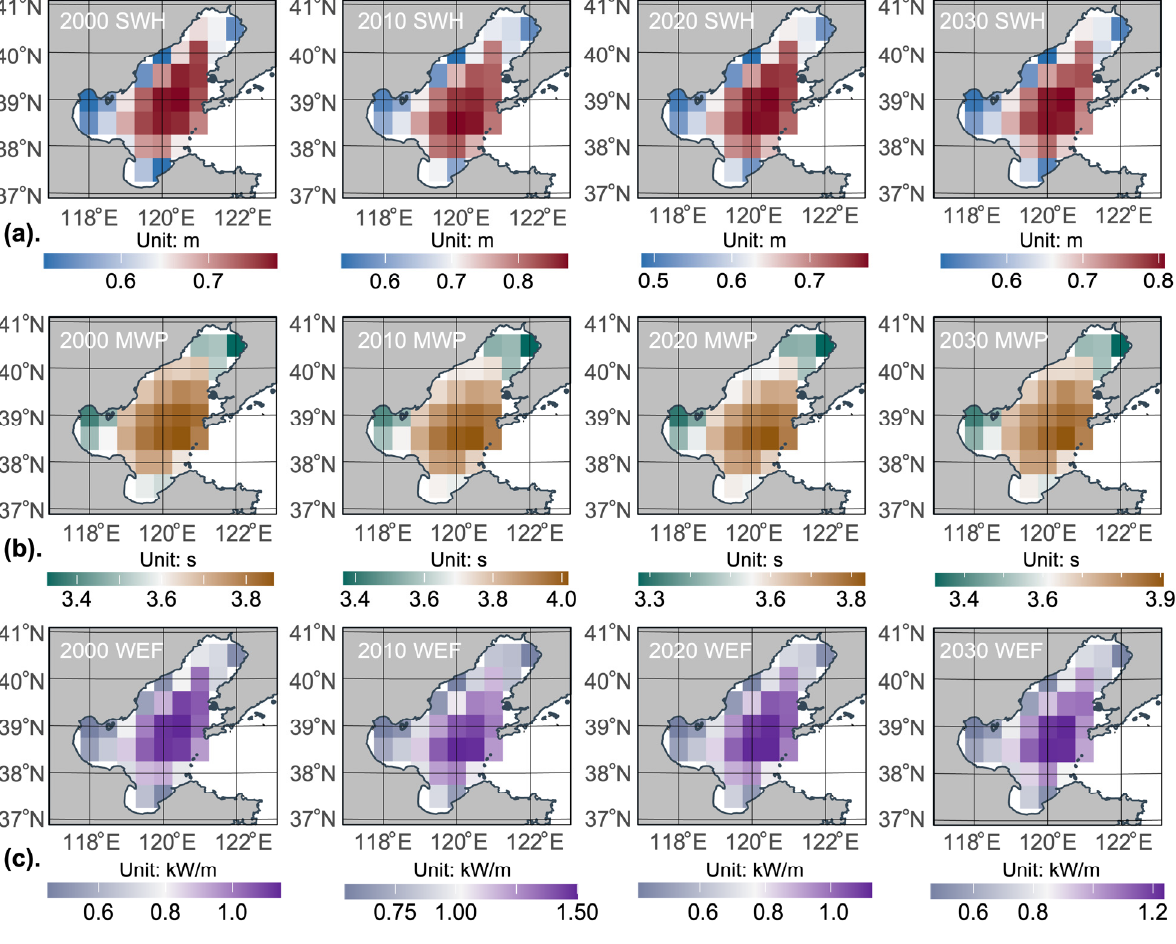
Figure 7. Mean significant wave height ( a ), mean wave period ( b ), and wave energy flux ( c ) in the